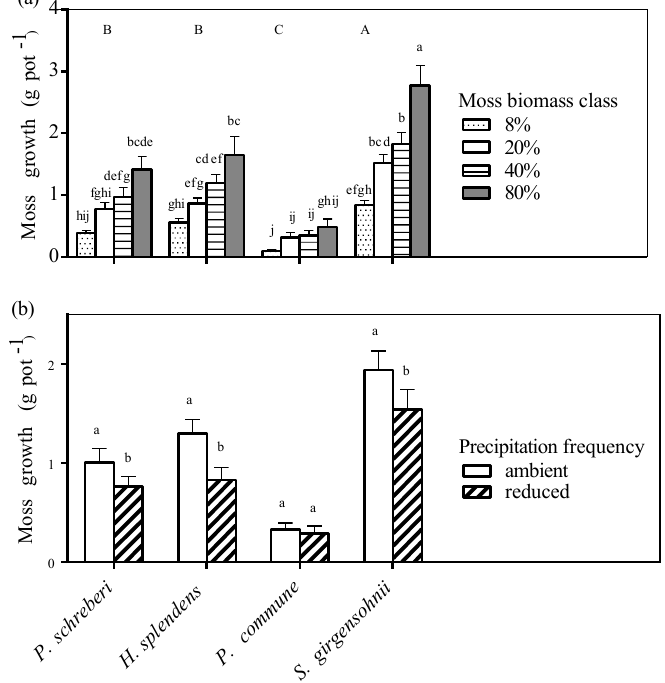
Figure 4. Moss biomass growth (dry weight) per pot of each of the four moss species during the course of the experiment: ( a ) averaged across precipitation regimes and expressed for each initial moss biomass class (MBC); and ( b ) averaged across all moss biomass classes (MBC) and expressed in relation to precipitation frequency (ambient and reduced); all moss species had the same starting dry weight for each biomass